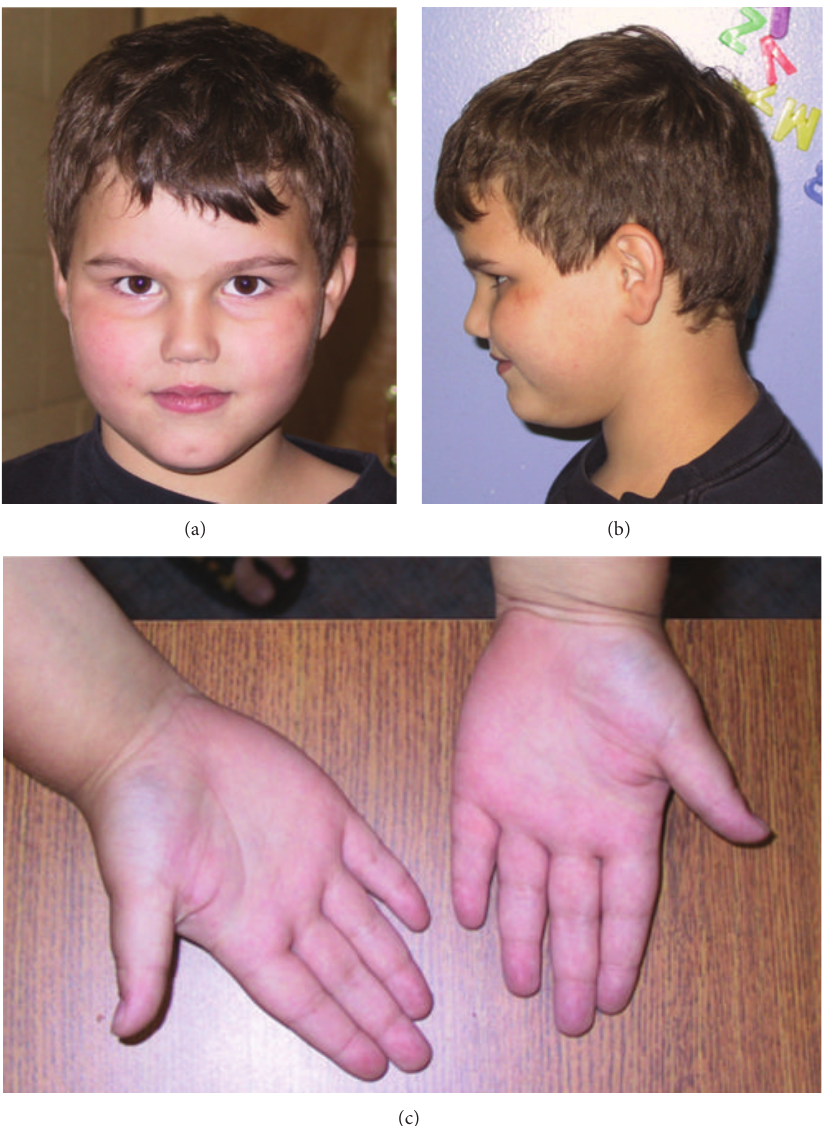
Figure 1: (a) Patient en face. (b) Patient profile. (c) Bridged palmar creases, fifth finger clinodactyly on the